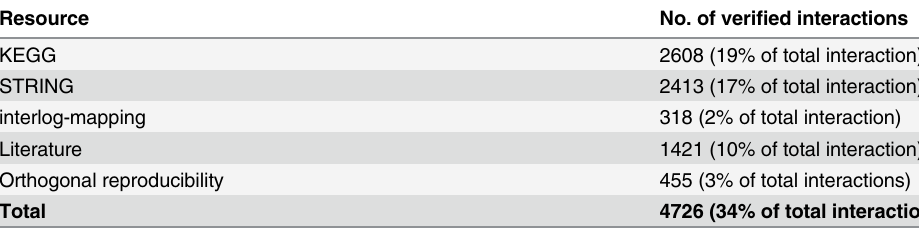
Table 1. Contribution of the orthogonal resources in verification of TbCF